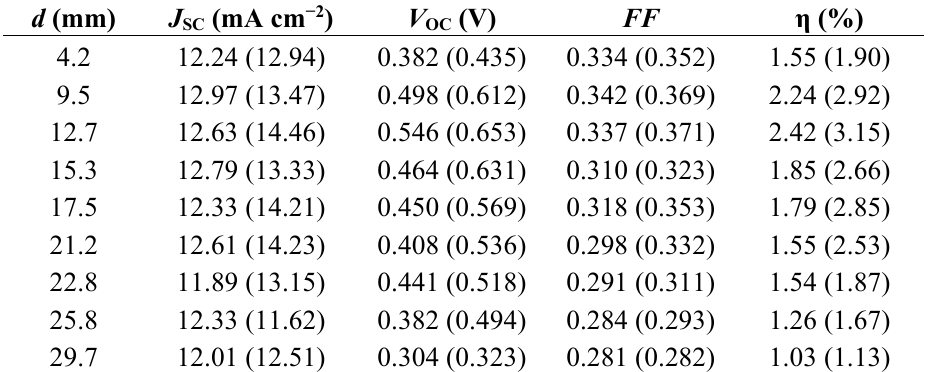
Table 1. Measured photovoltaic parameters (average and top) of TiO 2 /CH 3 NH 3 PbI 3 cells as a function of the distance ( d ) from the center of the cell.